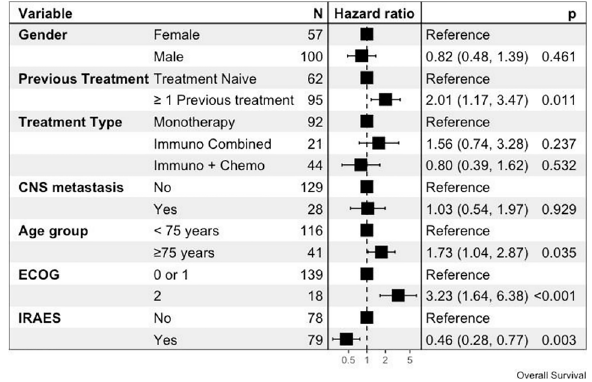
Figure 4. Results from Forest Plot models for overall survival (OS). Legend: CNS: Central nervous system; IRAES: Immune-related adverse